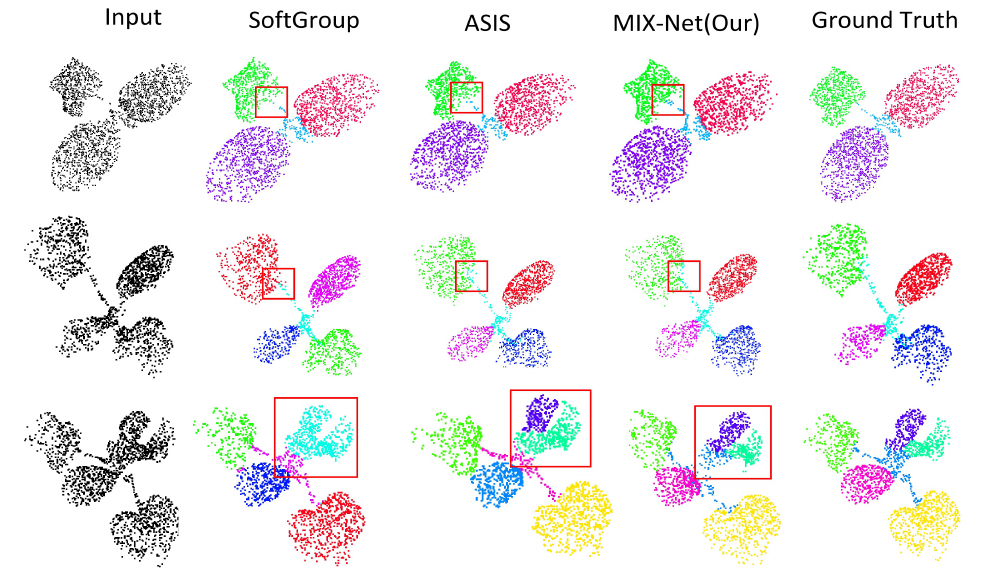
Figure 7. The qualitative instance segmentation comparison on the three species. SoftGroup and ASIS are compared with our MIX-Net. The parts with segmentation errors are highlighted by red dotted